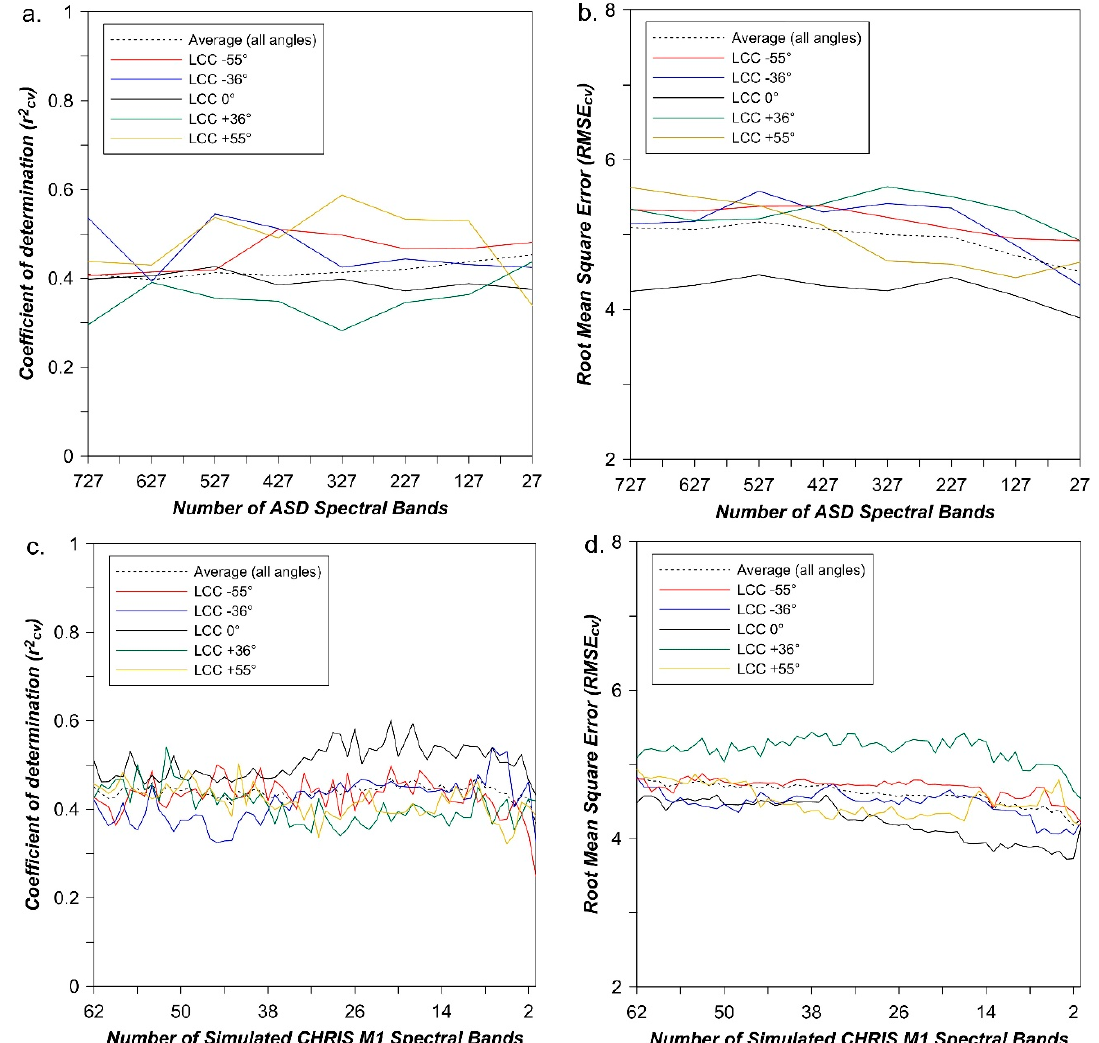
Figure 7. r 2 cv ( a , c ) and RMSE cv ( b , d ) for LCC models at each VZA using the full spectrum ASD data ( a , b ) and CHRIS M1 simulated data ( c , d ) averaged across study sites.